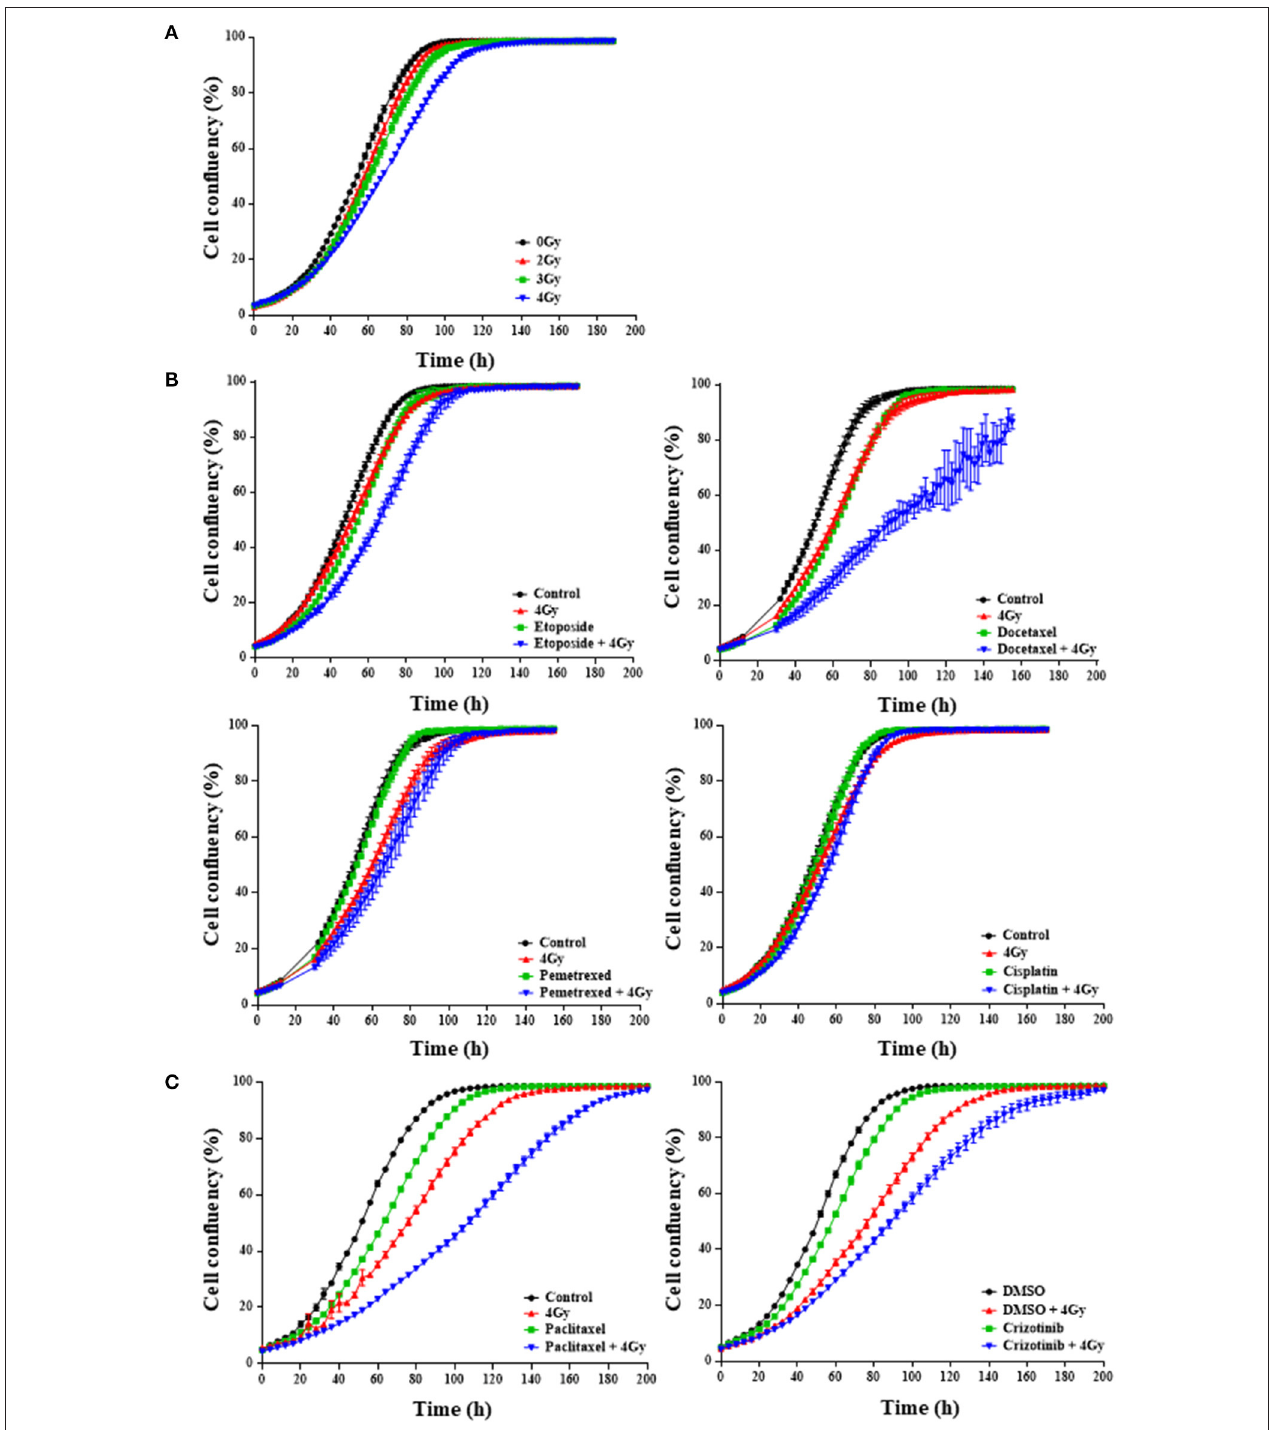
FIGURE 1 | First-line chemotherapeutics combined with radiation delays H1299 monolayer growth. IncuCyte TM FLR analysis of cell confluency (%) over time for NCI-H1299 cells growing in monolayer treated with increasing RT doses between 2 and 4Gy (A) and the selected RT dose of 4Gy in combination with/without chemotherapeutic agent at 0.77 microM (B) , 2.5 nM for paclitaxel ( C , left) or 0.4 microM for crizotinib ( C , right). “Control” indicates the use of medium. Alternatively, DMSO was used where indicated. A minimum of two independent experiments and 6–18 wells/condition/experiment were tested. Mean and standard error of the mean are